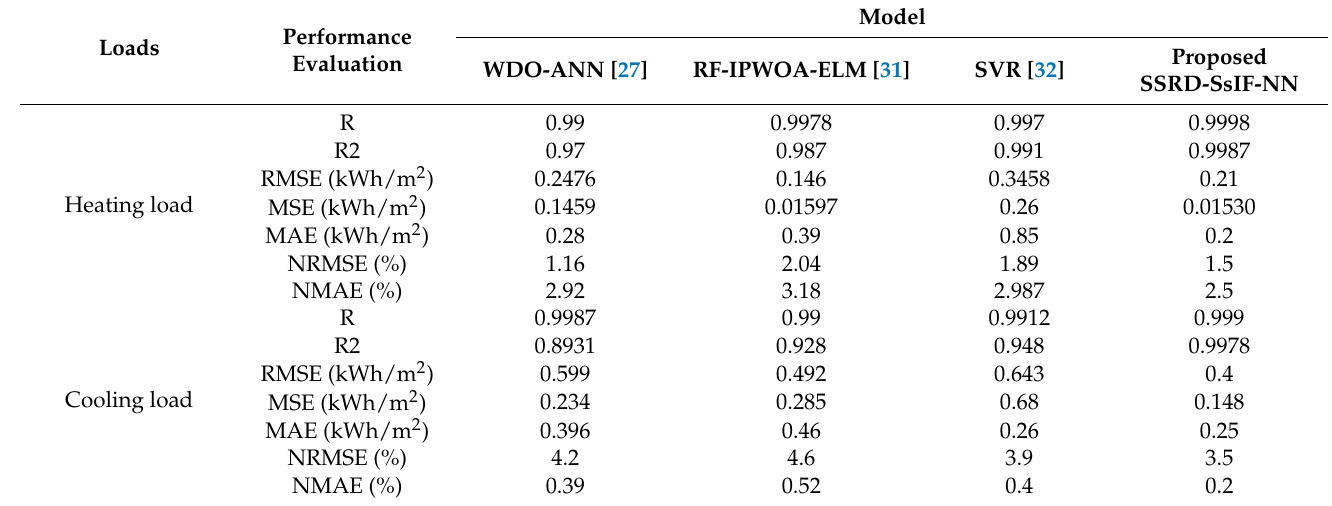
Table 3. Comparative analysis of the proposed method and conventional